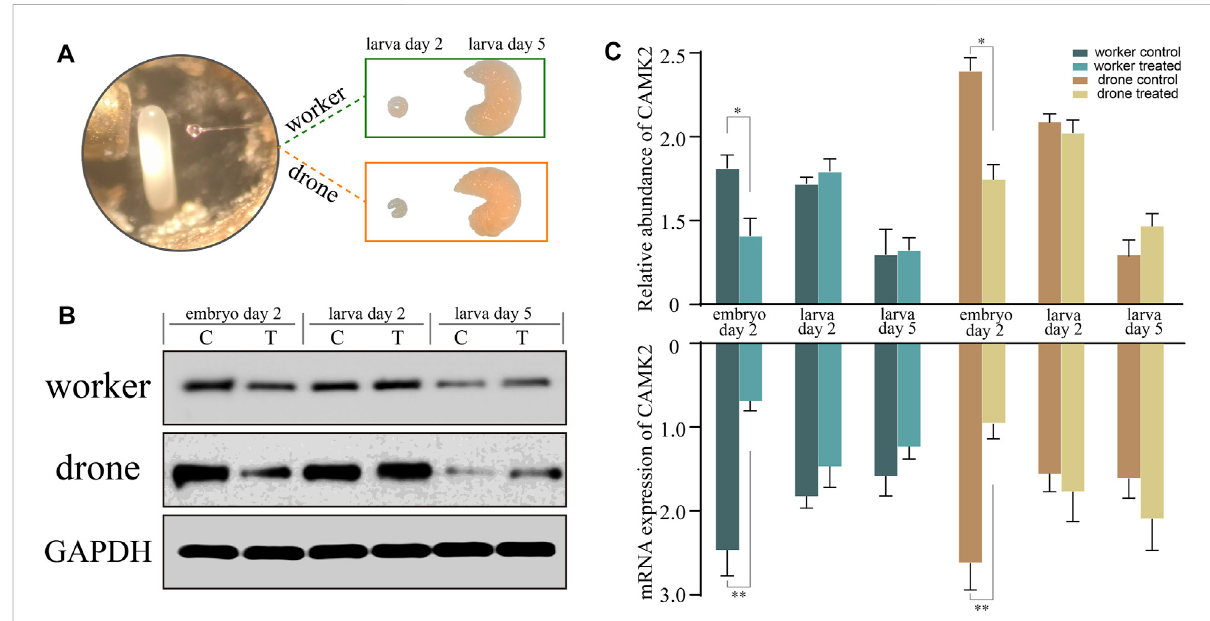
FIGURE 8 RNA interference analysis of key kinase calcium/calmodulin-dependent protein kinase II (CAMK2). (A) The newly laid embryos of worker and drone aresubjectedto geneknockdown andincubated to larvae. (B) The Western-Blottingbands ofCAMK2andGAPDH. (C) The relativeexpression values of CAMK2 protein and mRNA in the worker and drone at the three stages are normalized by GAPDH. The error bar is the standard deviation. The asterisks show signi fi cant differences ( p <